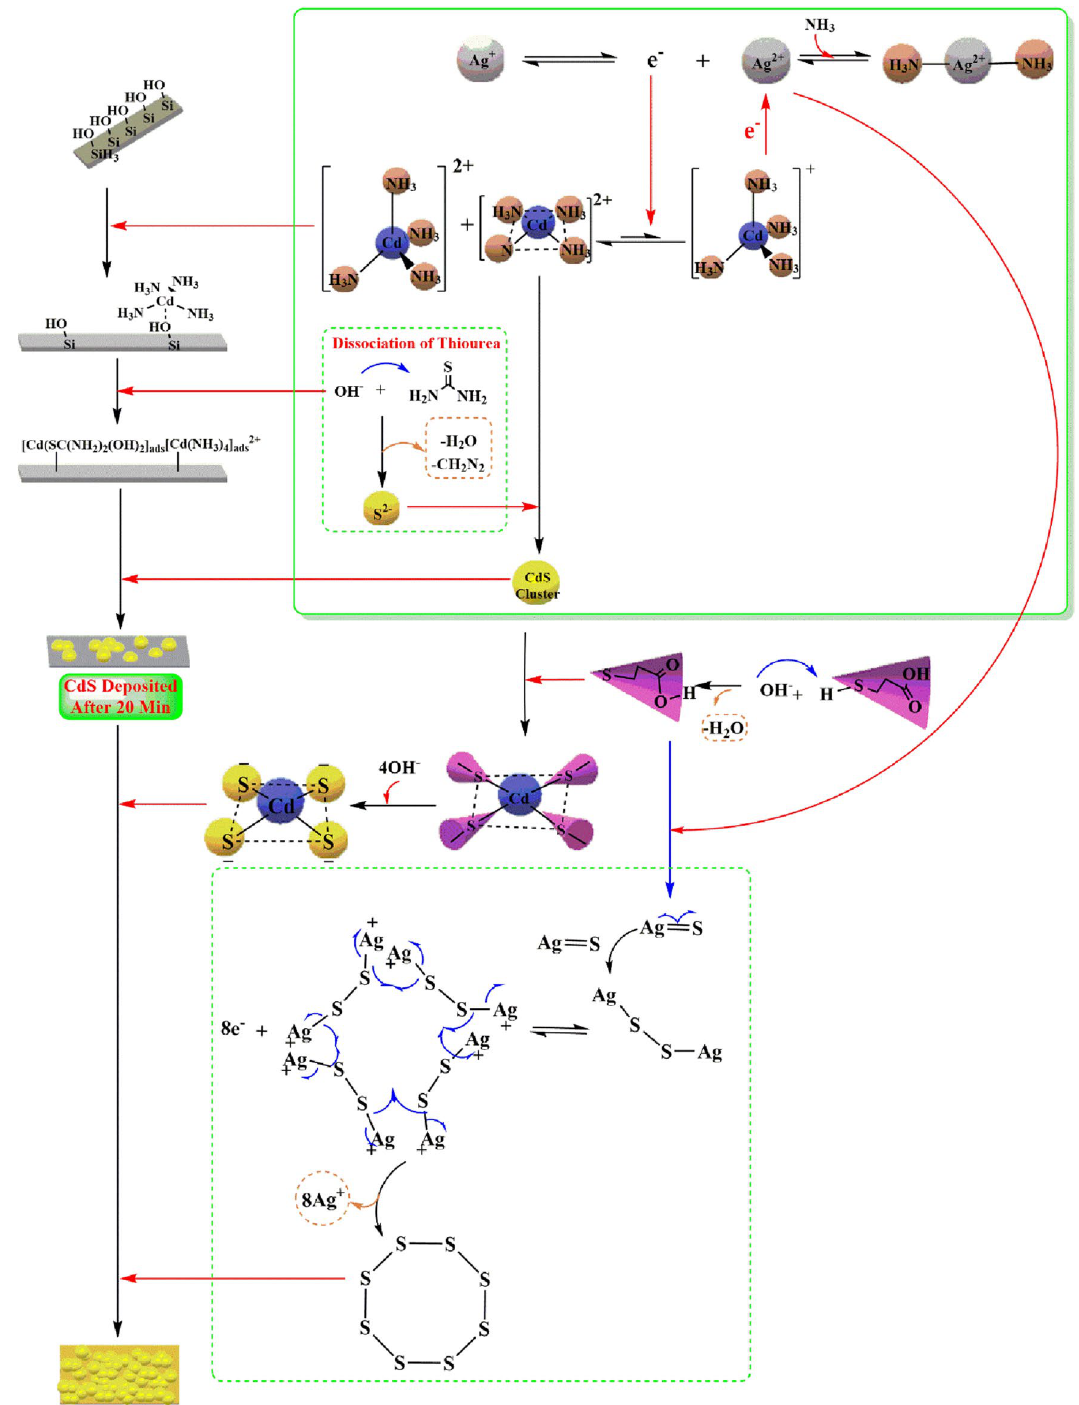
Figure 11. The growth mechanism of CdS + Ag + MPA in